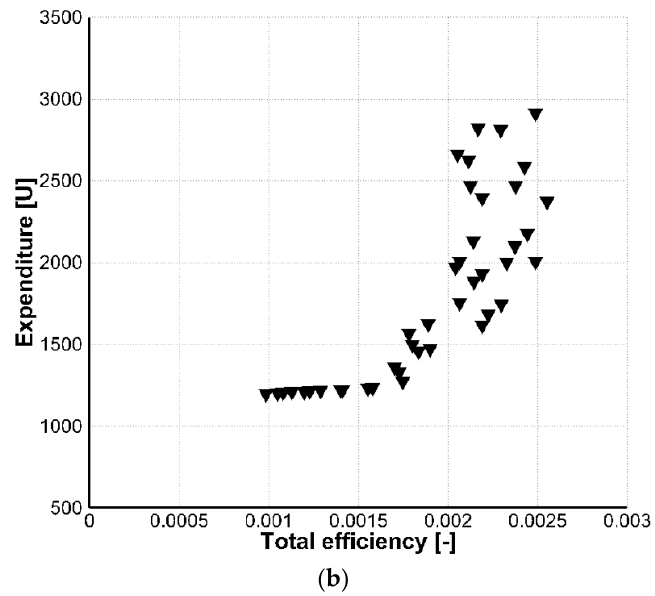
Figure 7. ( a ) Tradeoff between power output and total efficiency for the Manzanares SCPP; and ( b ) Tradeoff between total efficiency and expenditure for the Manzanares SCPP.